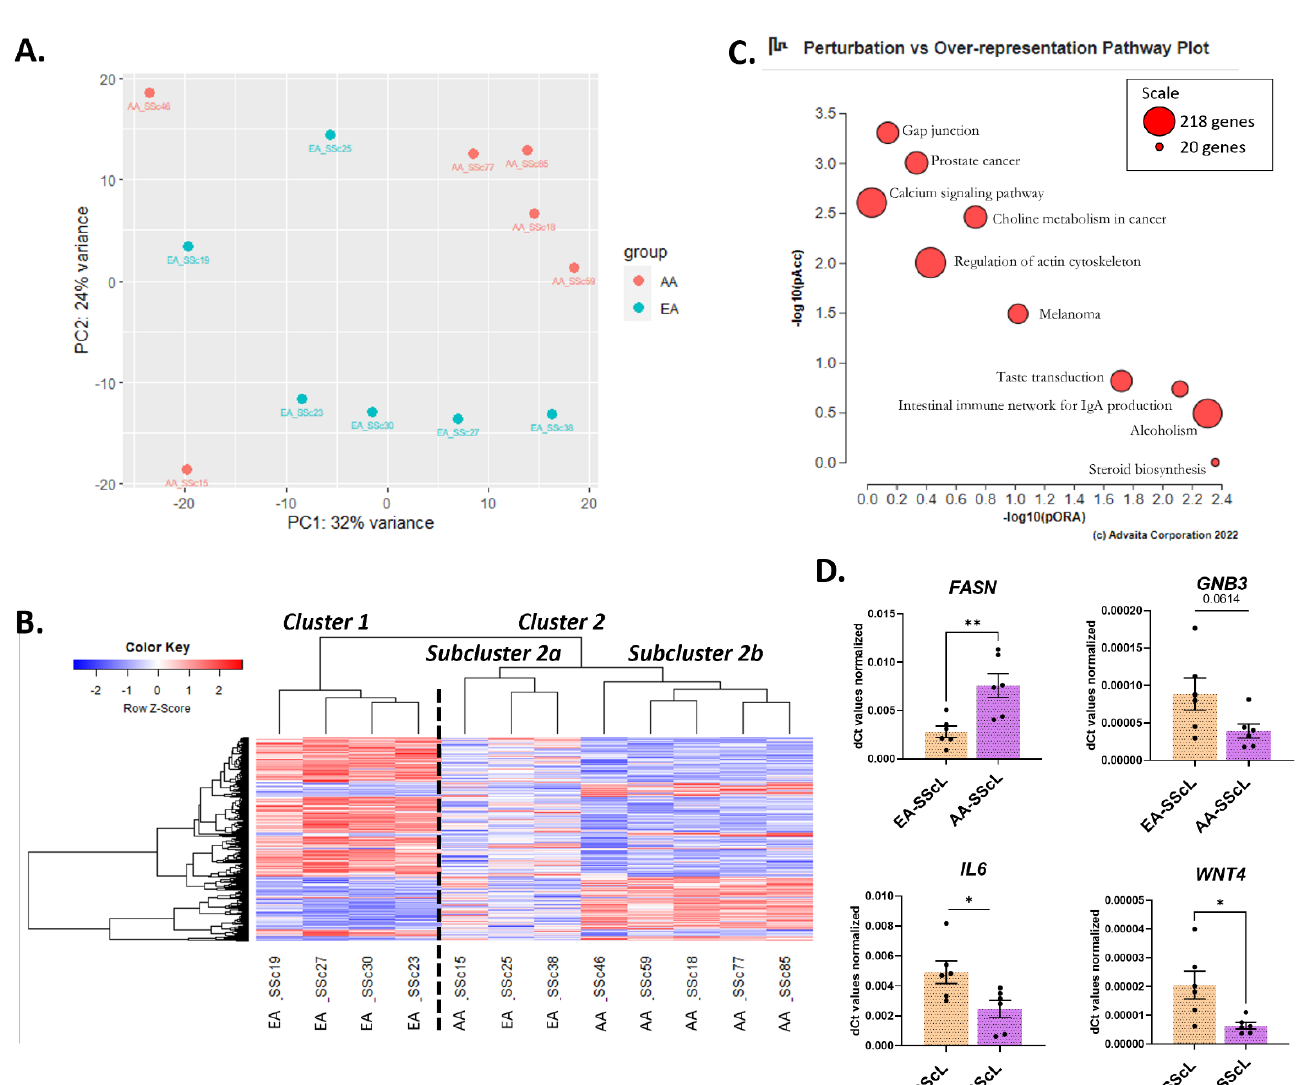
Figure 5. Characterizing the differences in disease state between AA and EA SScL fibroblasts. ( A ) PCA plot for “AA-SScL vs. EA-SScL” DE analysis. ( B ) Heatmap of the genes with a q-value < 0.1 in the “AA-SScL vs. EA-SScL” DE analysis. ( C ) Perturbation vs. over-representation pathway plot for “AA-SScL vs. EA-SScL.” Dots representing the top 10 impacted pathways are positioned by their p -values from 2 different analyses: the impact analysis (pAcc) vs. over-representation analysis (pORA). The size of each plot denotes the total number of genes in the corresponding KEGG pathway (for visualization, this number is log(2) scaled). ( D ) Validation of selected genes by qPCR in EA-SScL and AA-SScL samples. * p ≤ 0.05, ** p ≤ 0.01. Mean ±